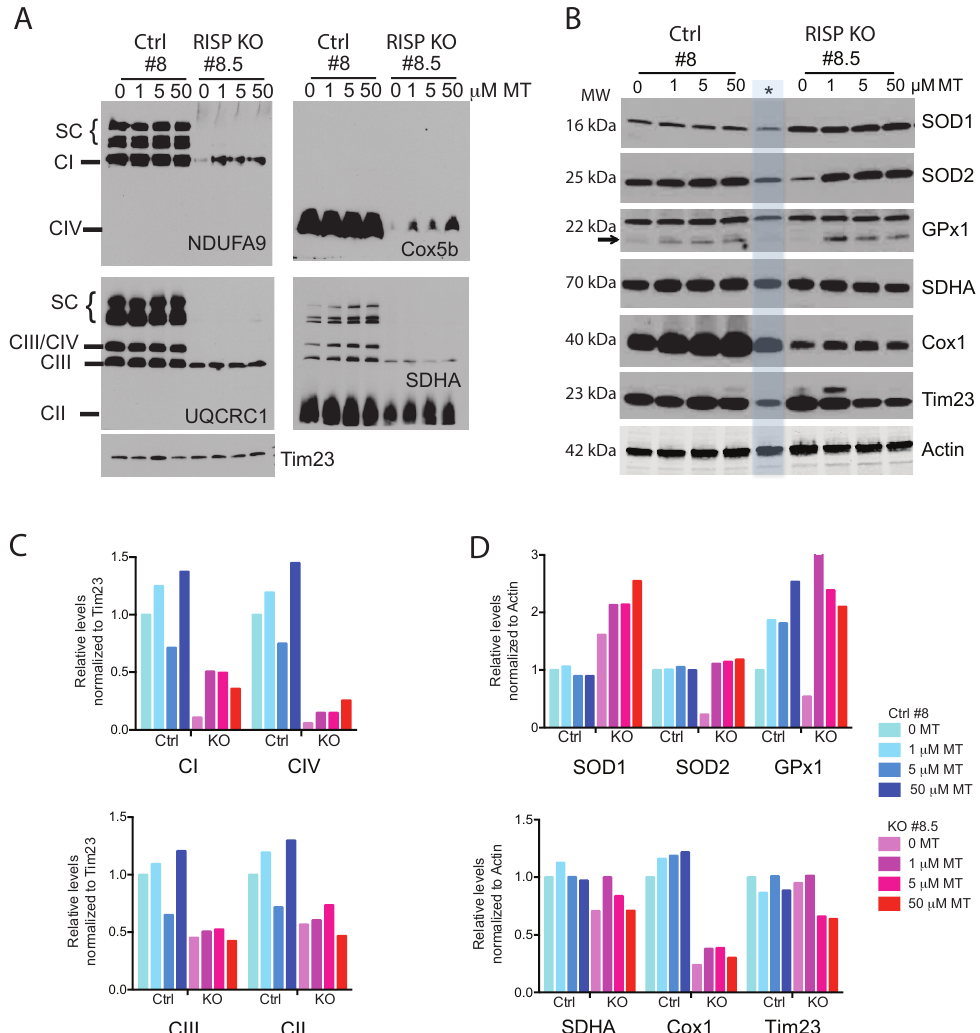
Figure 2. Mitochondrial supercomplexes in RISP fibroblasts treated with mitoTEMPO. Control (#8) and RISP KO (#8.5) mouse fibroblasts were incubated with different concentrations of mitoTEMPO (MT) for 24 h. Cell homogenates were prepared for the analysis of ( A ) SCs by BN-PAGE and western blot to detect SCs, CI, CIII, CIV and CII using antibodies against NDUFA9, UQCRC1, Cox5b and SDHA subunits respectively or ( B ) Steady-state level of various mitochondrial proteins by SDS-PAGE and western blot. Tim23 was used as loading control for BN-PAGE and actin was used as loading control for SDS-PAGE. Asterisk and dimmed blue bar denote unrelated sample to this study (Ctrl fibroblast exposed to hypoxia). ( C , D ) Densitometry of blots in ( A , B